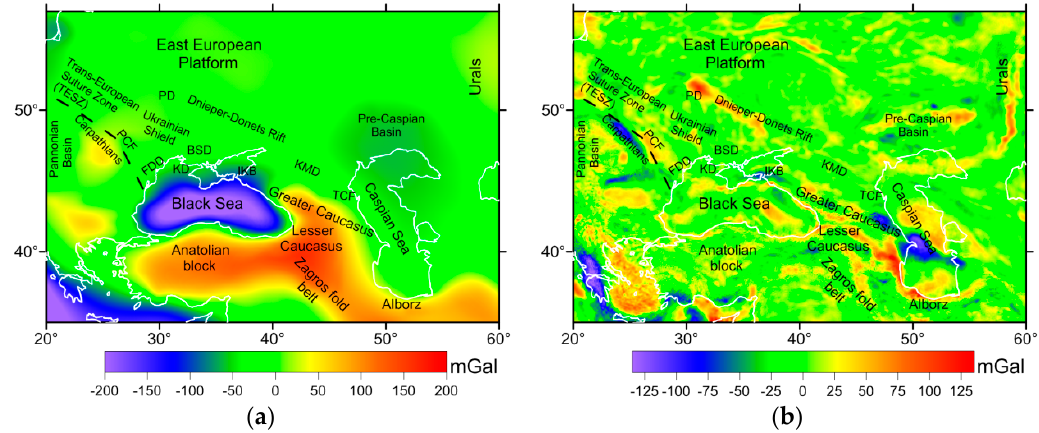
Figure 5. ( a ) Isostatic correction; ( b ) isostatic residual gravity anomalies. See text for detailed explanations.